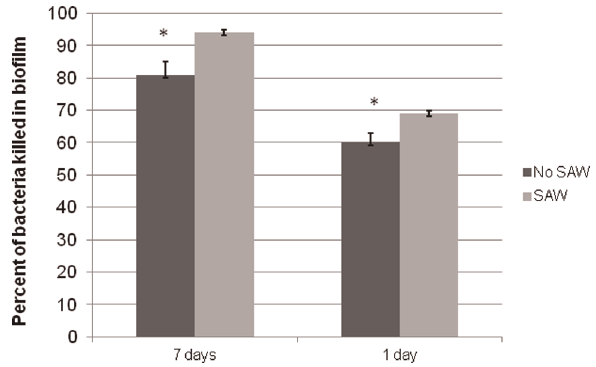
Figure 7. The Effect of SAW on Neutrophil Killing of Biofilms. Biofilms were cultured on silicone discs for 10 days. SAW was applied for either 7 consecutive days starting at day 3 to day 10 or for one day on day 10. During the 7 day applications, SAW was applied at each indicated time for 6 hr intervals (the battery life of the SAW device). For the one day application, SAW was applied for 90 mins on day 10. Freshly isolated human neutrophils were then added for 90 mins at 37 u C on day 10 to biofilm-containing discs. As indicated, the plates were then further exposed to SAW during the incubation with neutrophils. At the end of the neutrophil co-incubation, the discs were removed, washed 3 6 in PBS and sonicated to release the bacteria from the discs as described under Materials and Methods. Bacterial growth was then assessed as described [13]. Samples were taken before the addition of the neutrophils and after the 90 mins co-incubation with neutrophils to assess viable bacteria (n=2 done in triplicate). The percent of bacteria killed was calculated based on the control wells not incubated with neutrophils compared to those incubated with neutrophils. Student t-tests reveals significance at the p , 0.05